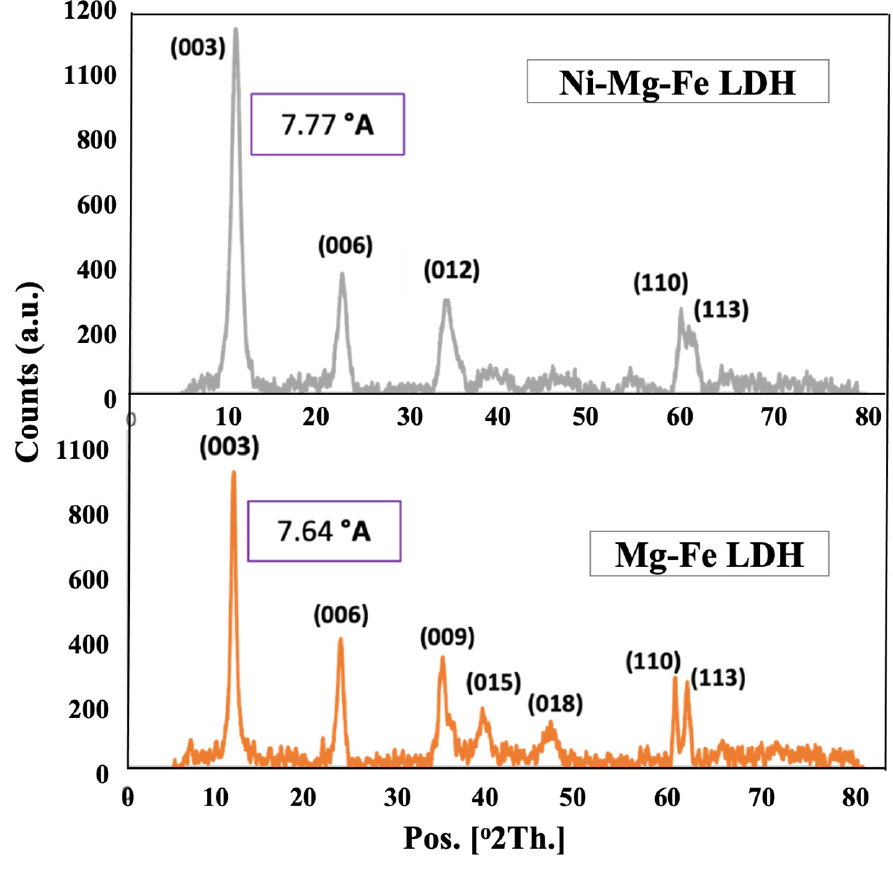
Figure 3. XRD patterns of the Mg-Fe LDH and Ni-Mg-Fe LDH Figure 3. XRD pa tt erns of the Mg-Fe LDH and Ni-Mg-Fe LDH catalysts.